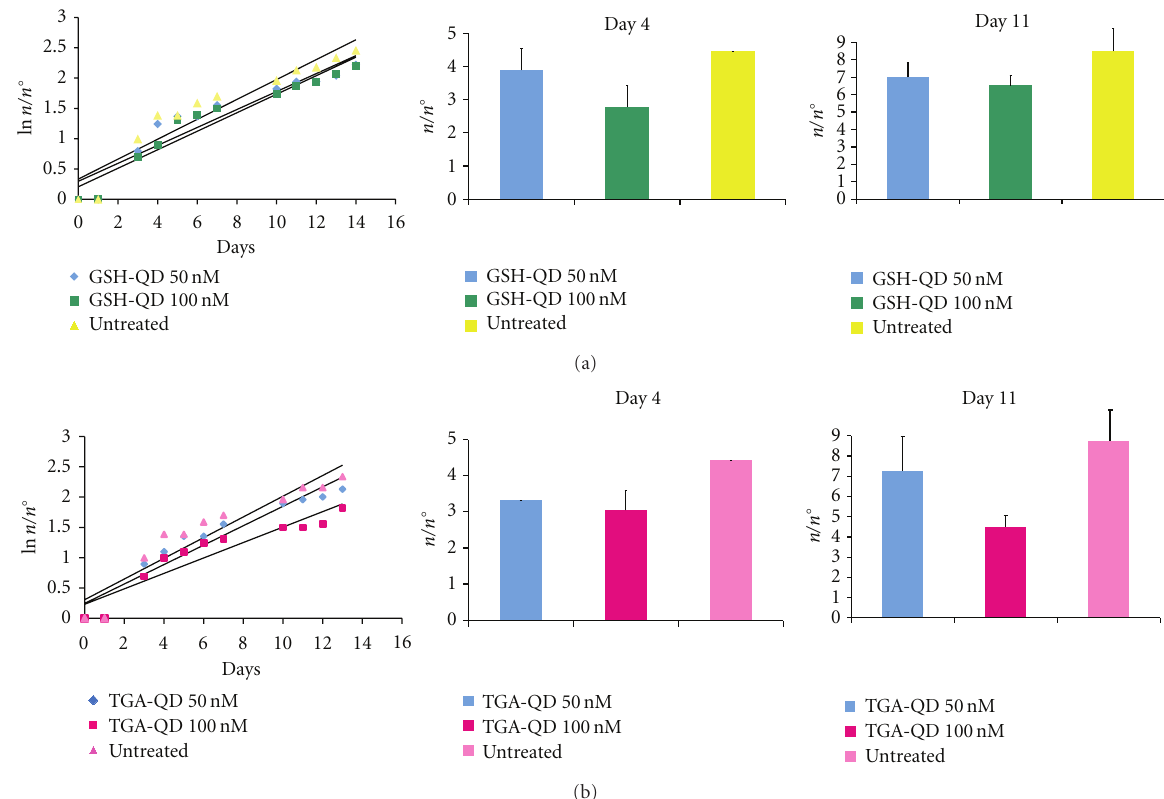
Figure 5: Influence of the QD treatment on Hydra population growth rate. Population growth test started with a population of four full- grown Hydra , incubated 2h with the indicated QD, washed out, and monitored every day for bud detachment. Hydra were treated with GSH-QDs, dark and light green bars, (a), or TGA-QDs, dark and light pink bars, (b), washed, and equilibrated in culture solution or not treated (blue bars). The individuals were inspected daily and counted under a stereomicroscope. The logarithmic growth rate constant ( k ) is the slope of the regression line using the standard equation of logarithmic growth: ln( n/n 0 ) = kt . Significant di ff erences between growth rates of Hydra population treated with TGA-QD or untreated were obtained comparing linear regression slopes using ANOVA two-way test ( P < . 005). On the right panel, n/n ◦ ratio ( ± SD) extrapolated from growth curves at days 4 and 11 is